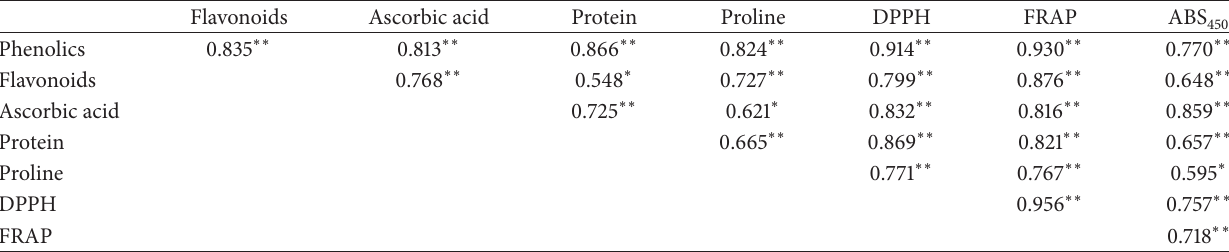
Table 5: Correlation among biochemical parameters, antioxidant properties, and color intensity.